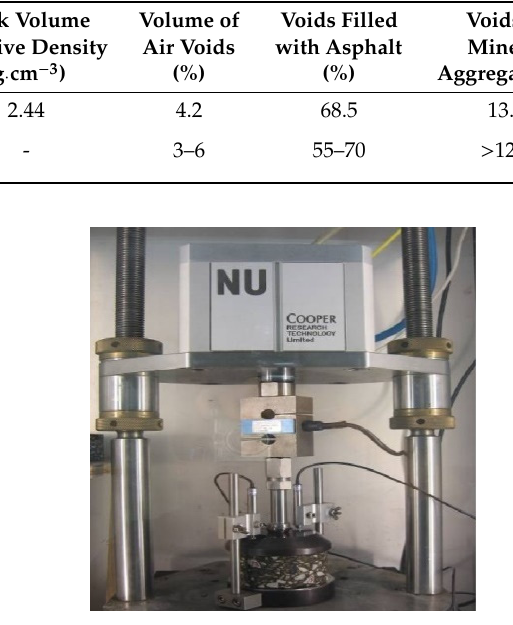
Figure 4. Dynamic creep test of asphalt mixture.